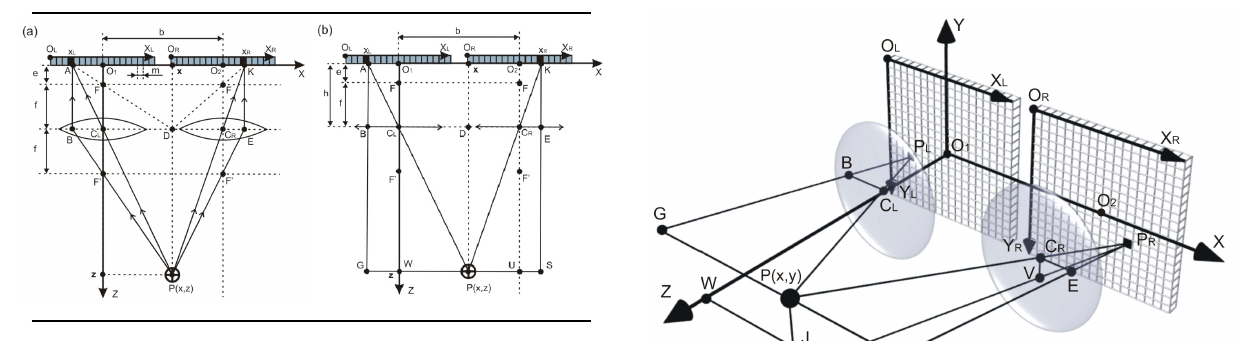
Figure 1: Top view of the stereoscopic system with parallel optical axes. (a) Optical scheme for paths of rays in the stereoscopic system. (b) Geometric scheme of the stereoscopic system. Figure 2: Side view of the stereoscopic system with parallel optical axes. (a) Optical scheme for paths of rays in the stereoscopic system. (b) Geometric scheme of the stereoscopic system.